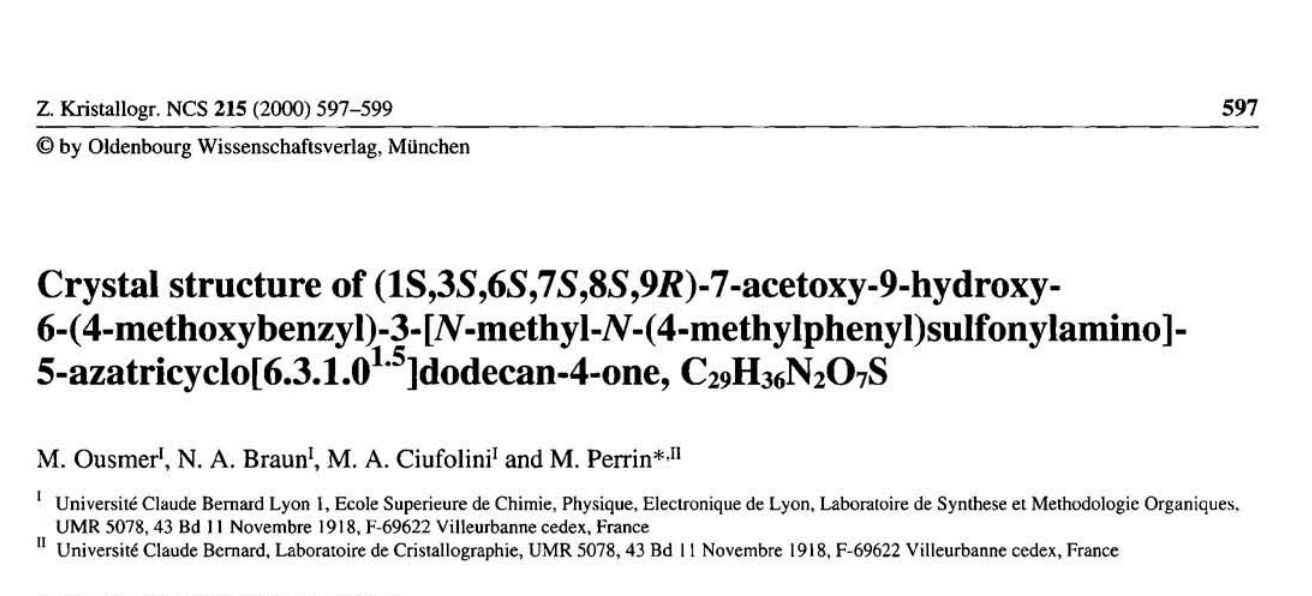
Table 1. Data collection and handling.